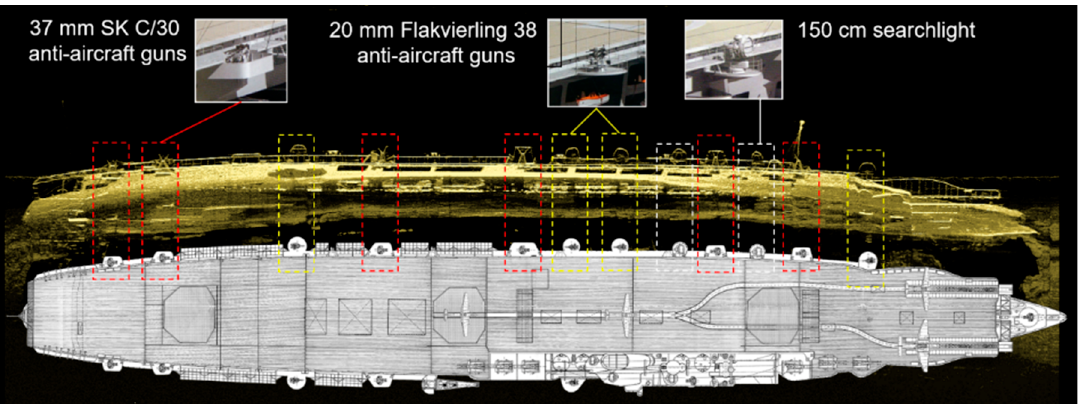
Figure 24. Identification of the port side of the shipwreck.